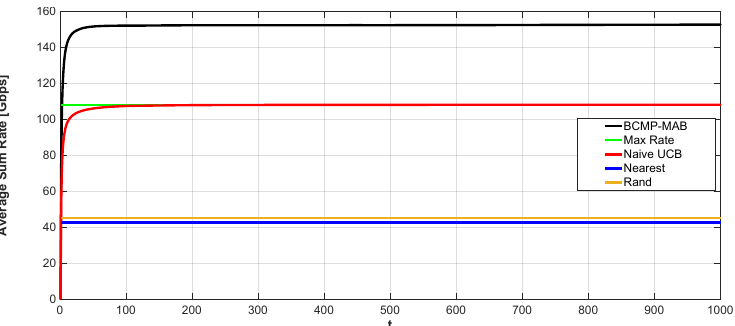
Figure 10. Average sum rate convergence against the time horizon using M = 100, and N =